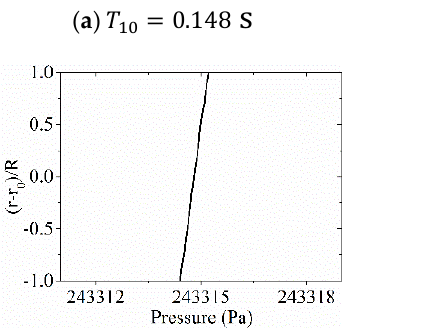
Figure 23. Local pressure distribution at S1 monitoring position of different time ( 𝑇 10 = 0.148 s and 𝑇 11 = 0.164 s ).